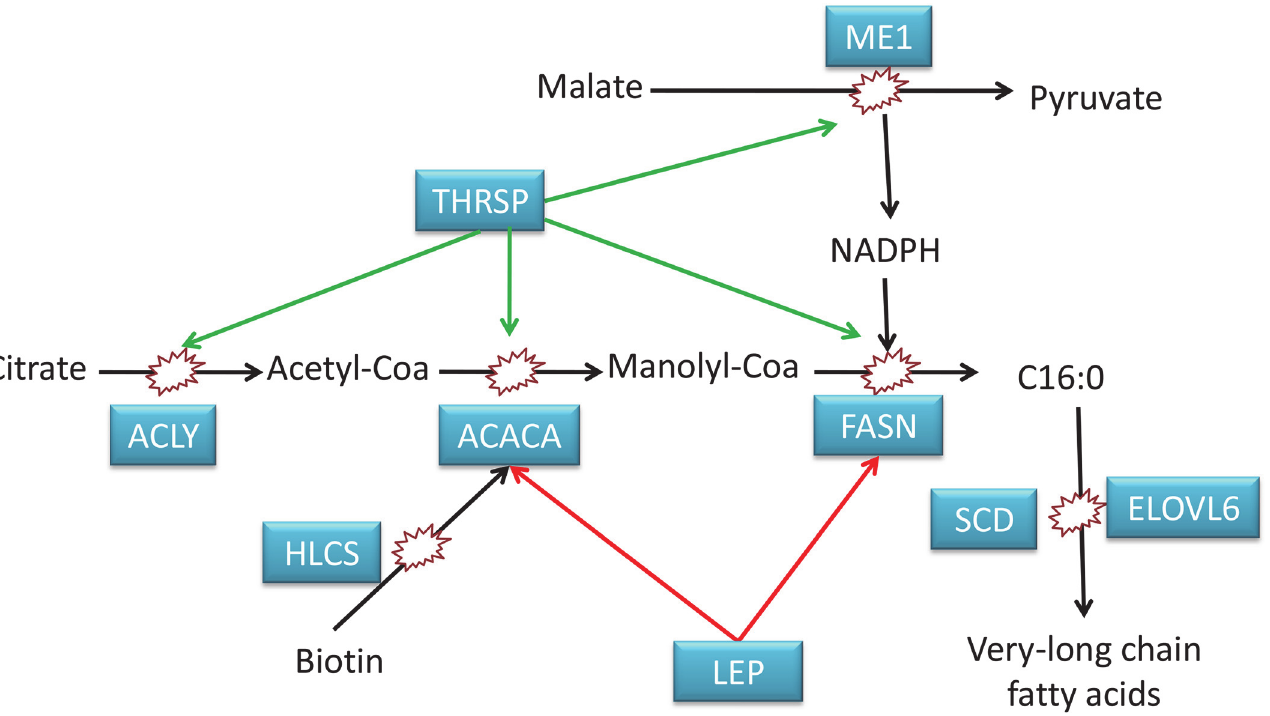
Fig 8. The function of DEGs in the de novo fatty acids synthesis. Black arrow means enzymes take part in the de novo fatty acids synthesis; red arrow means inhibiting effect; green arrow means promoting effect; blue quadrangle means up-regulation expression genes between BH and BL in adipose tissue